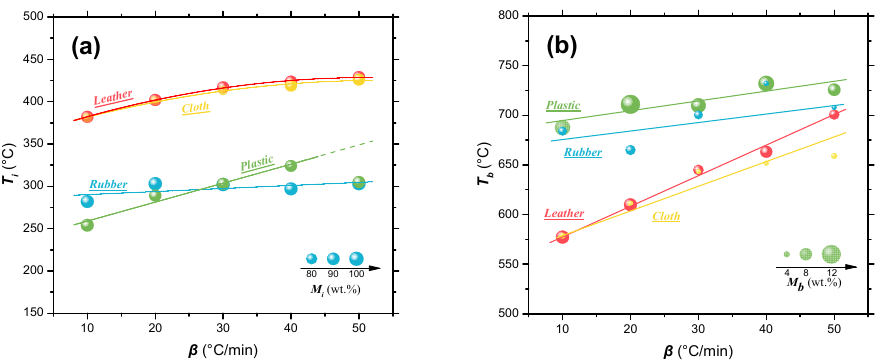
Figure 2. The ignition temperature ( a ) and burnout temperature ( b ) and the corresponding residual mass in the combustion process of four polymeric wastes at different heating rates.